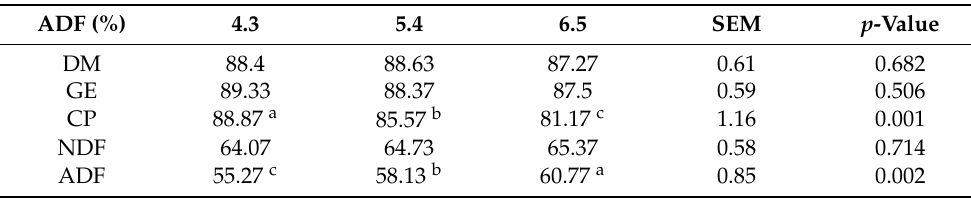
Table 3. Effect of dietary acid detergent fiber (ADF) levels in gestation diets on apparent total digestibility (%) of